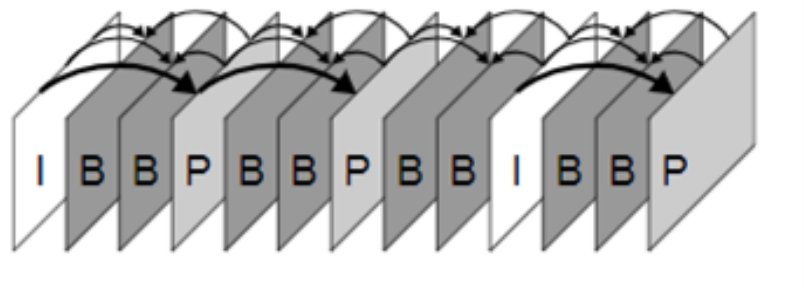
Figure 8. Intra (I) and inter (B and P) frames in a video